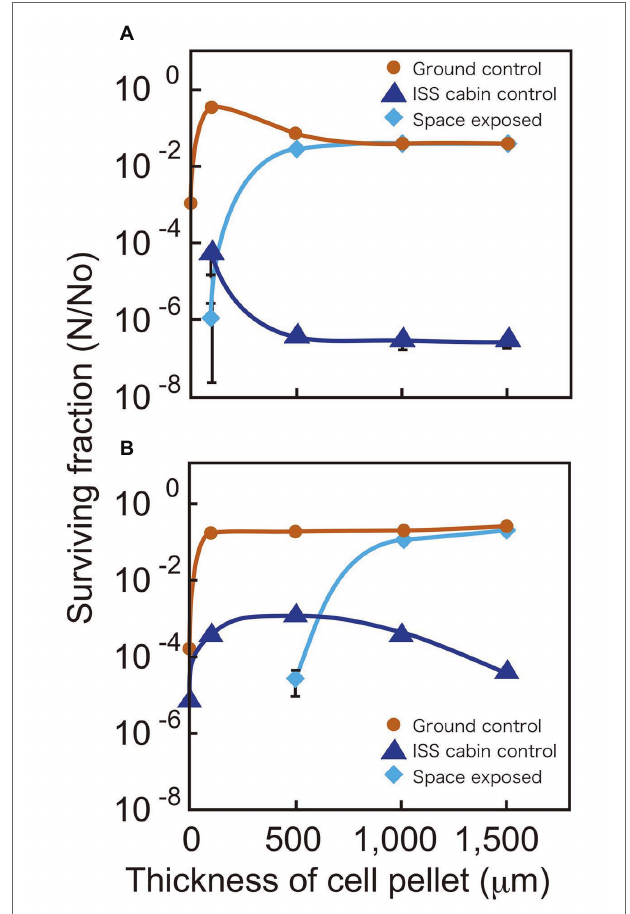
FIGURE 2 | Surviving fractions of D. radiodurans R1 (A) and D. aerius TR0125 (B) after 3 years. Cells were under a MgF 2 window (UV >110 nm) when exposed to space (pale blue diamonds). The International Space Station (ISS) cabin (blue triangles) and the ground controls (brown circles) are also shown. Far left data on the vertical axis show the results of sample with about 1 μ m thickness. Some data points (1 μ m ISS cabin control and space exposed samples in A and 1 and 100 μ m space exposed samples in B) are not indicated because no surviving cells were detected. The actual thicknesses of the samples are presented in Supplementary Table 1 . Each error bar shows the standard error of the mean (SEM) of triplicate samples; most SEMs were small and covered by data